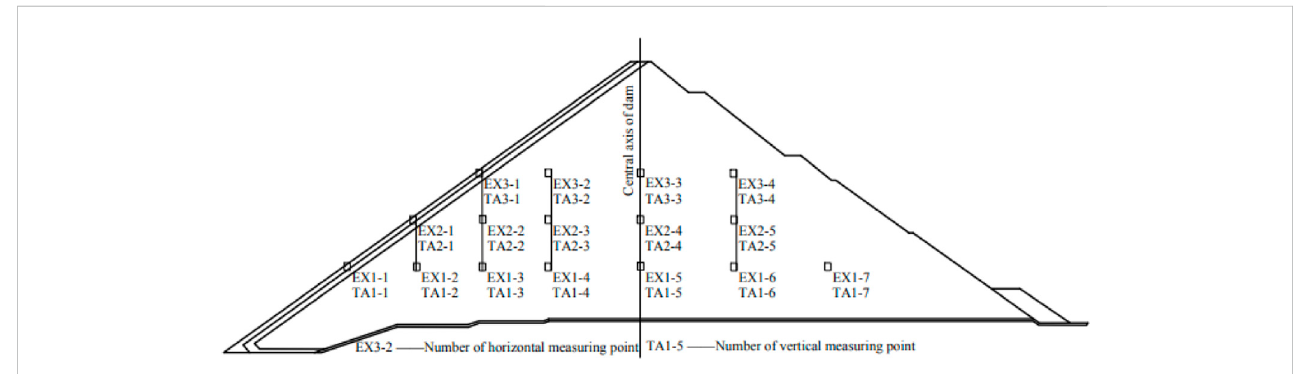
FIGURE 4 Layout of deformation monitoring instrument at riverbed cross